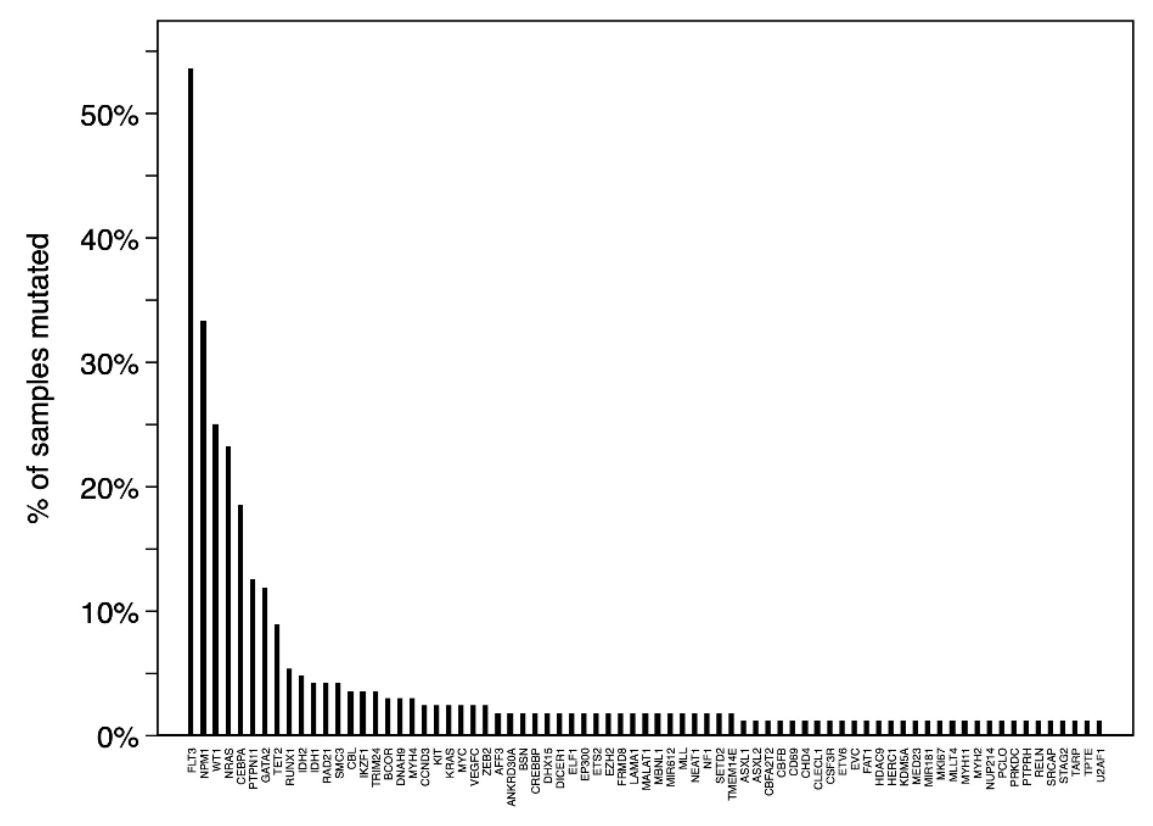
Figure 2. Recurrently mutated ( ≥ 2 samples) genes in pediatric normal karyotype AML.